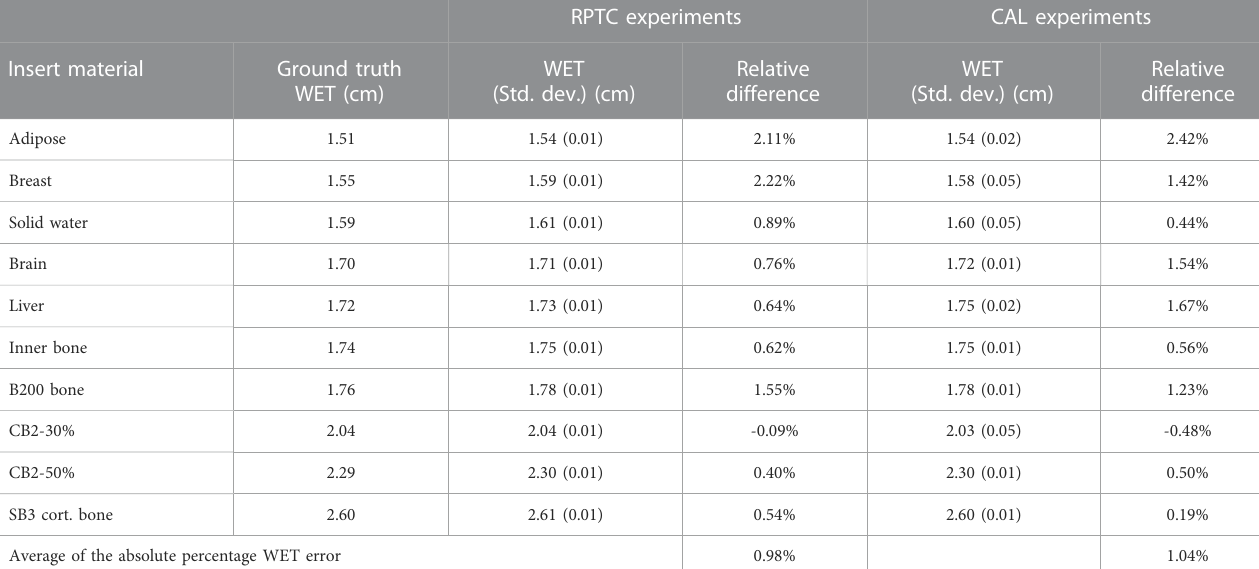
TABLE 1 CAL and RPTC, 13 mm air gap: Comparison of the experimentally determined WET with the ground truth WET (see section 2.4.1). RPTC experiments CAL